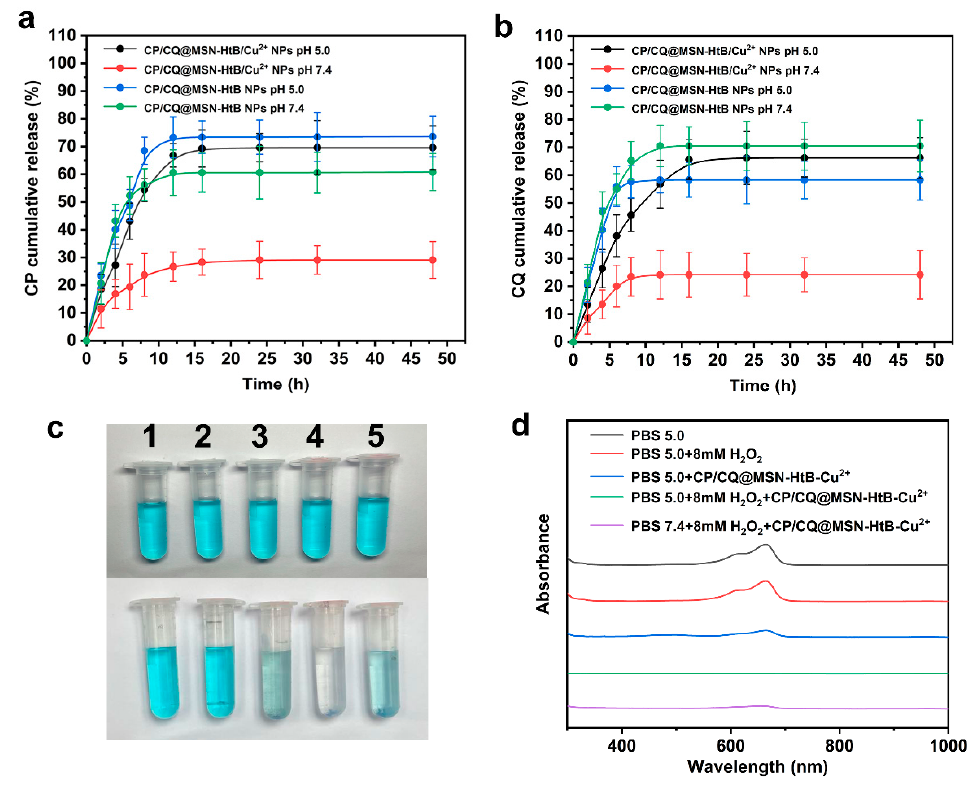
Figure 2. In vitro ( a ) CP and ( b ) CQ release profiles from CP/CQ@MSN − HtB